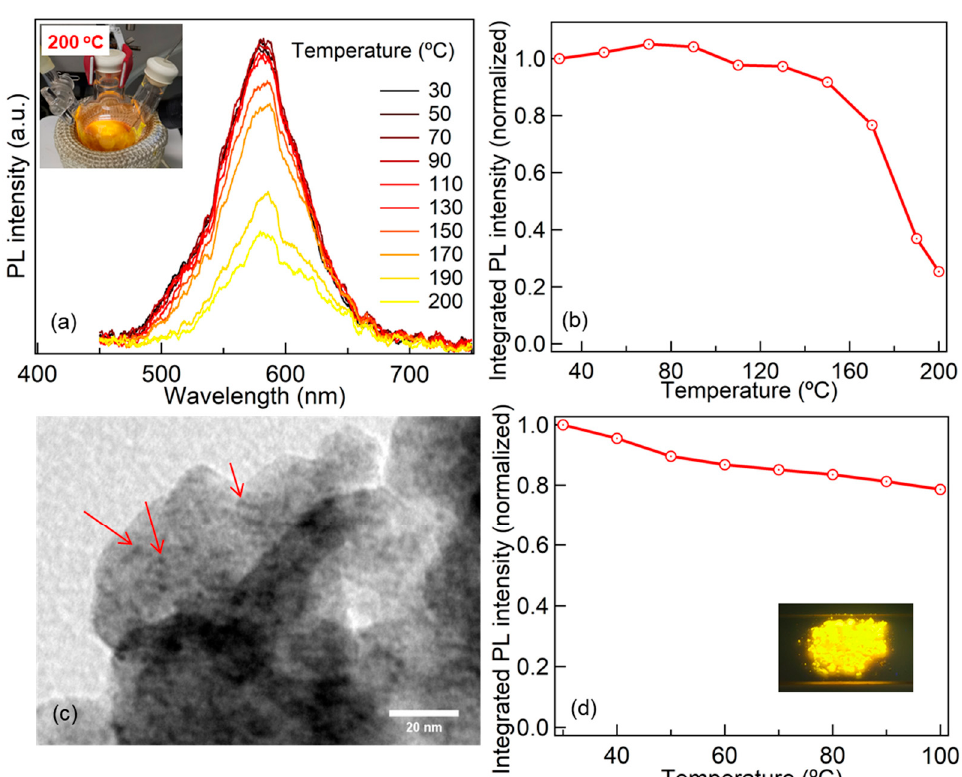
Figure 3. ( a ) Temperature-dependent PL spectrum of InP/ZnS/ZnS QDs growth solution under 365 nm excitation, the inset shows the bright growth solution at 200 °C; ( b ) the evolution of integrated PL intensity of the growth solution with respect to temperature; ( c ) a typical TEM image of the InP/ZnS/ZnS QDs@SiO 2 composite; ( d ) the evolution of integrated PL intensity of the InP/ZnS/ZnS QDs@SiO 2 composite with respect to temperature, the inset shows the bright compo- site.